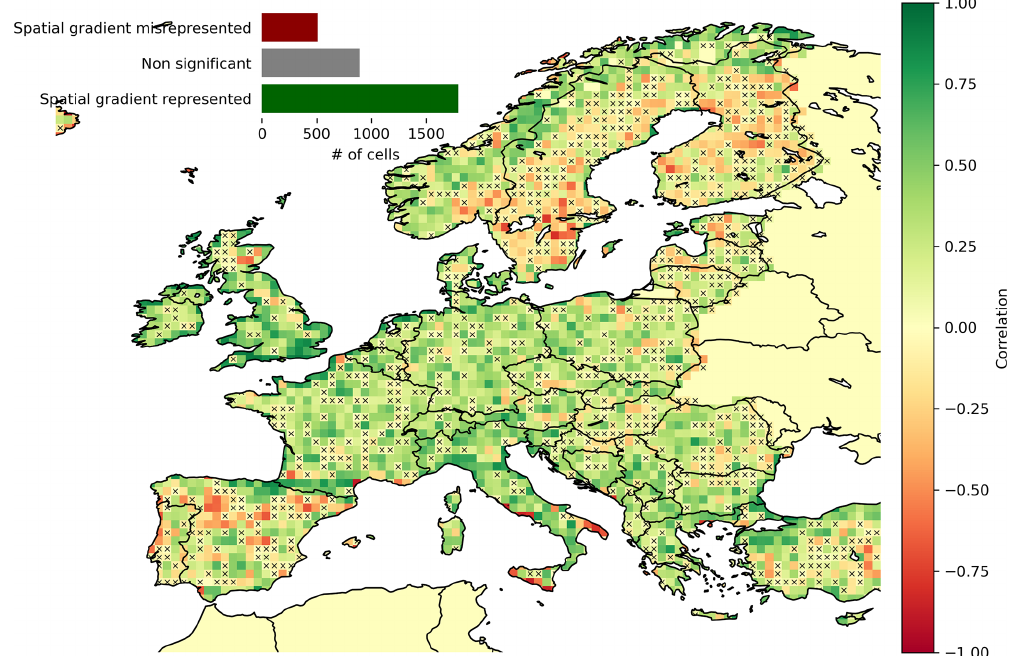
Figure 4. Correlation coefficient between NIRv and the downscaled SiB4 product from CTE-HR within 0 . 5 × 0 . 5 ◦ grid cells for July 2016. Non-significant values are marked with a cross. The inset in the upper left shows the number of grid cells where the spatial gradient was represented or misrepresented or no significant correlation was